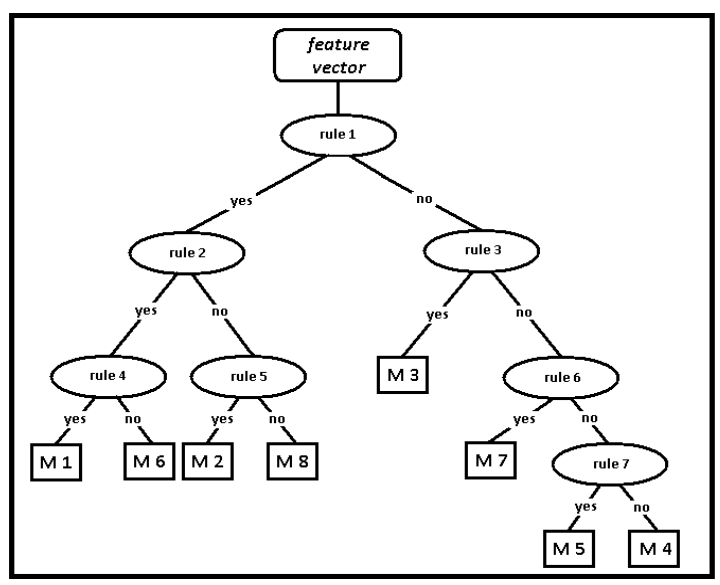
Figure 7. The RBA for classifying leg